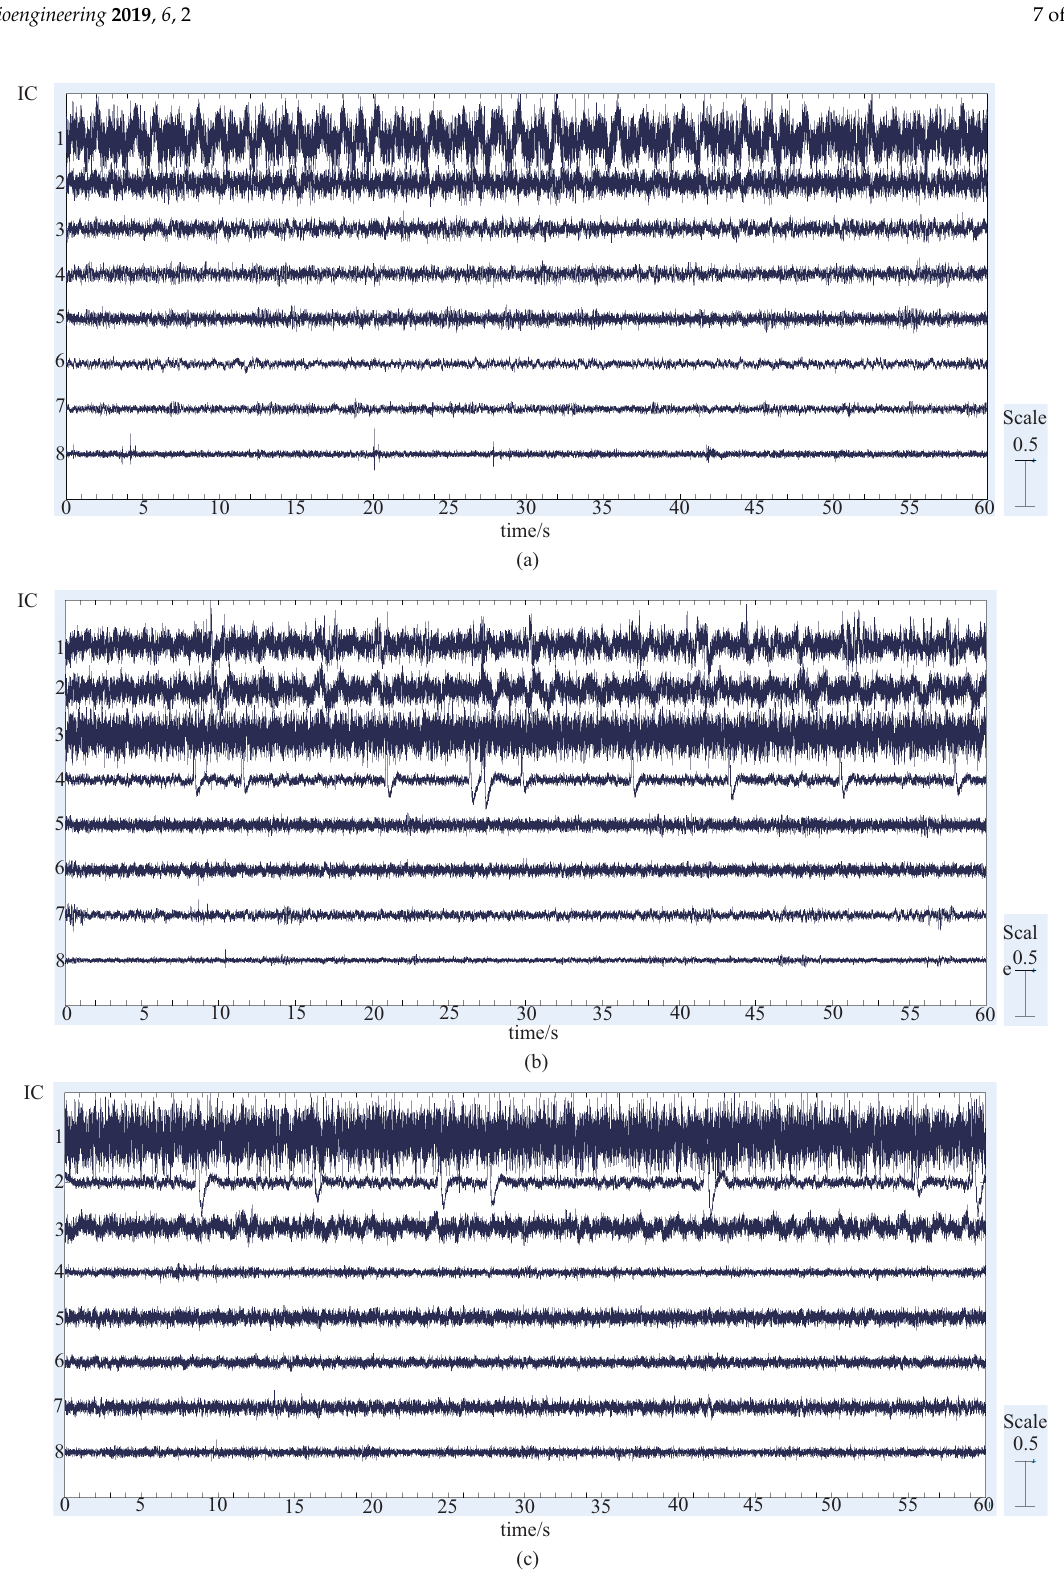
Figure 3. Independent component analysis results of three subjects ( a – c ) for one-minute data. The horizontal axis is the time in seconds, and the vertical axis is the amplitude of the independent component. The numbers from 1 to 8 correspond to 8 independent